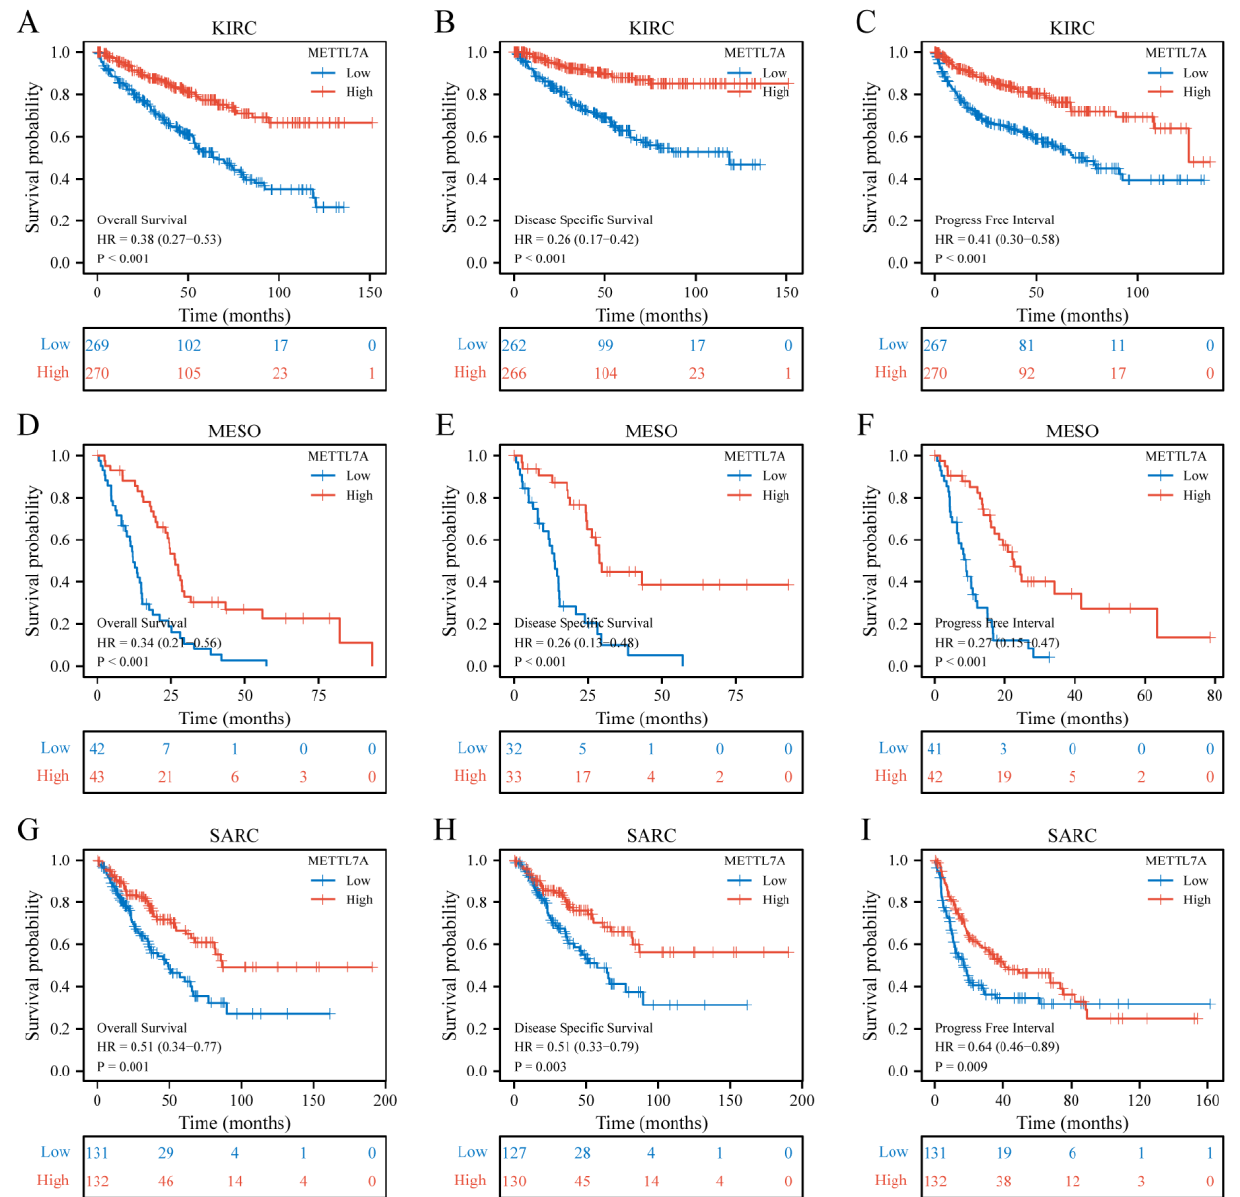
Figure 5. Correlations between METTL7A expression and the prognosis (OS, DSS, and PFI) of can- cers. ( A – C ) kidney renal clear cell carcinoma (KIRC); ( D – F ) mesothelioma (MESO); ( G – I ) sarcoma (SARC).